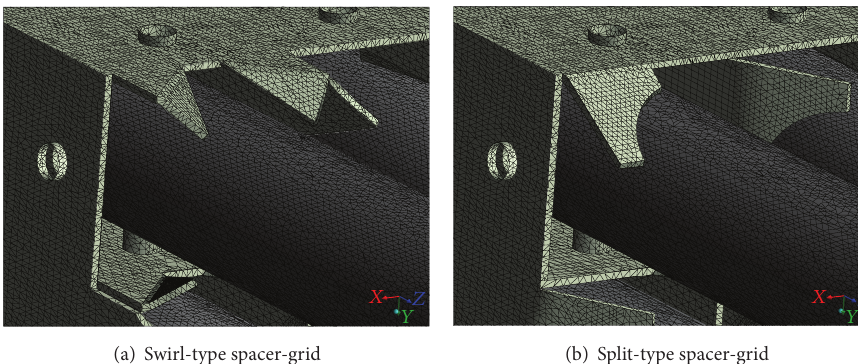
Figure 13: Mesh vane detail.